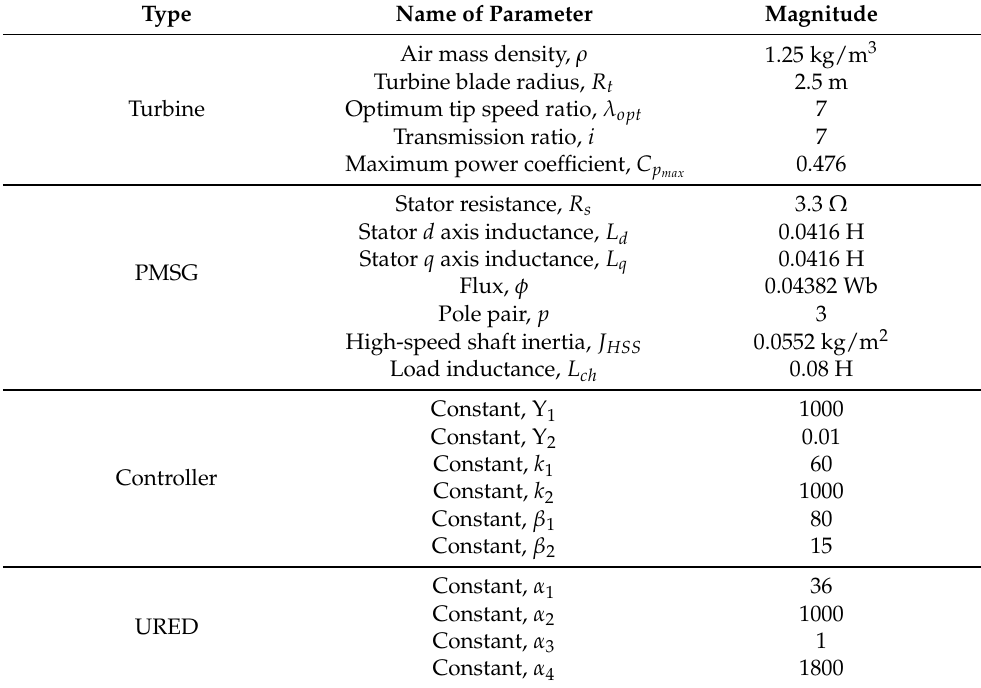
Table 1. Parameters of the system [12] and